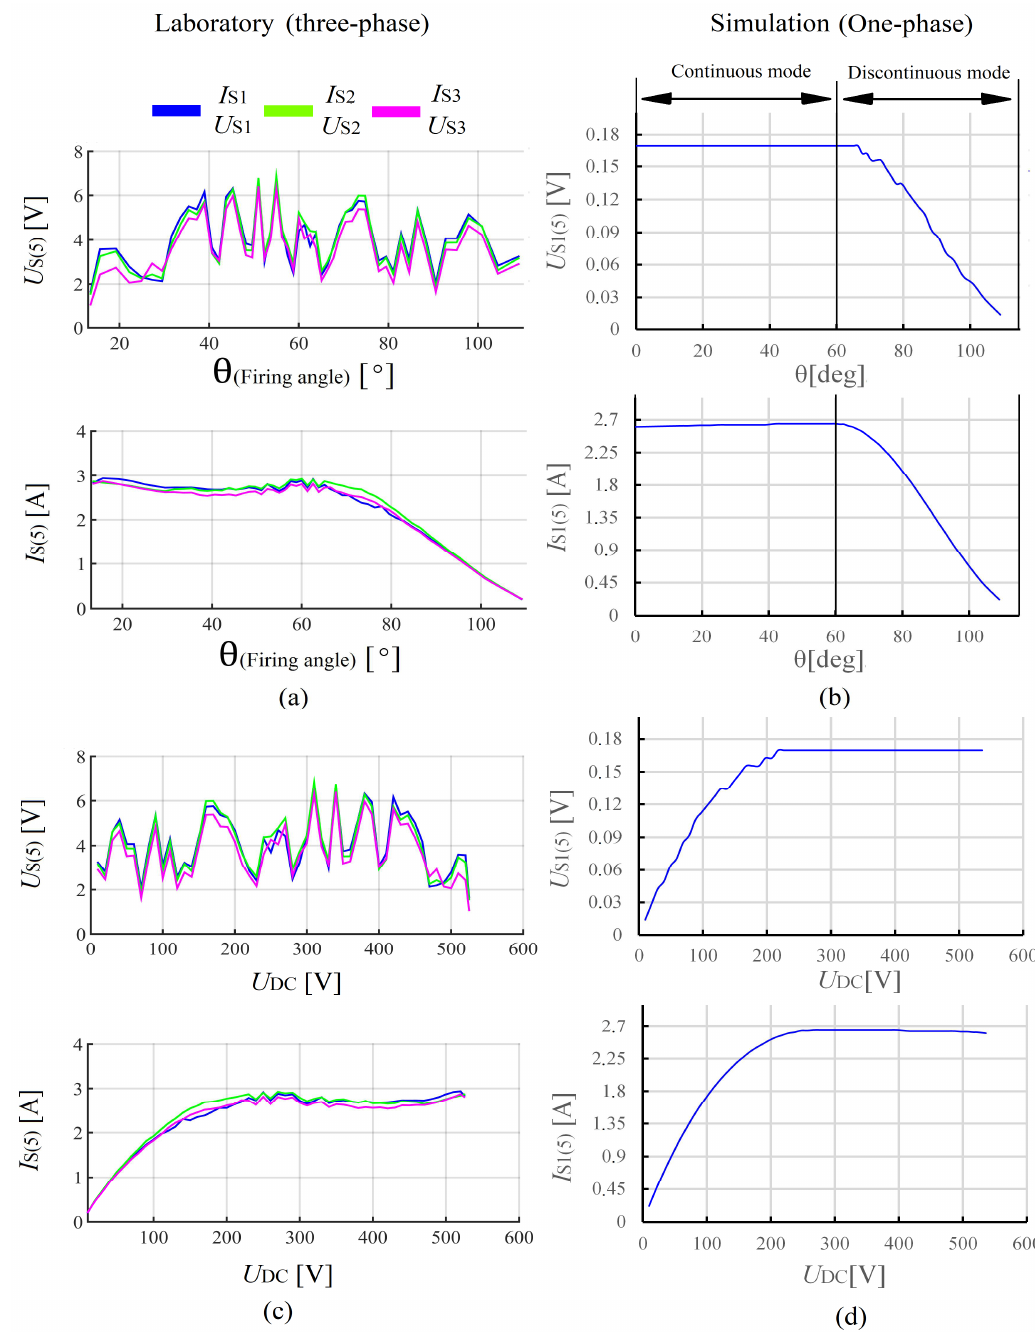
Figure 9. Comparison between the laboratory and simulated characteristics: PCC voltage and current 5th harmonic versus rectifier firing angle ( a , b ) and versus rectifier DC voltage ( c , d ).